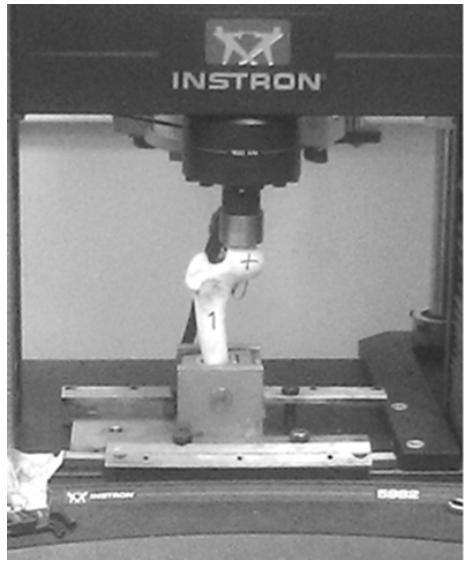
Figure 11. Testing procedure of the reinforced hip sample.